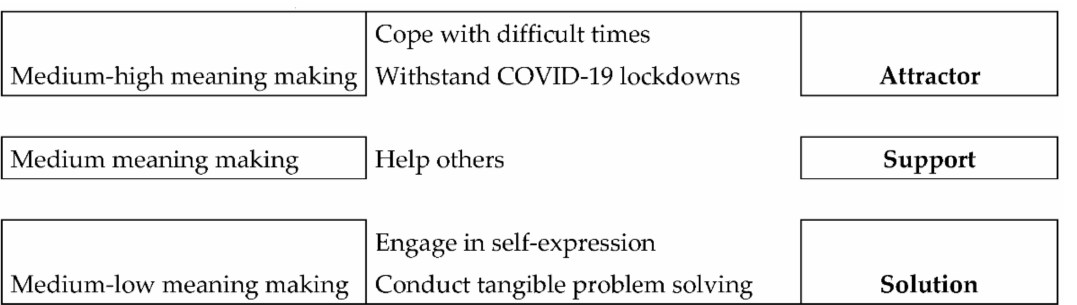
Figure 1. The interpretative creative modalities: attractor, support, and